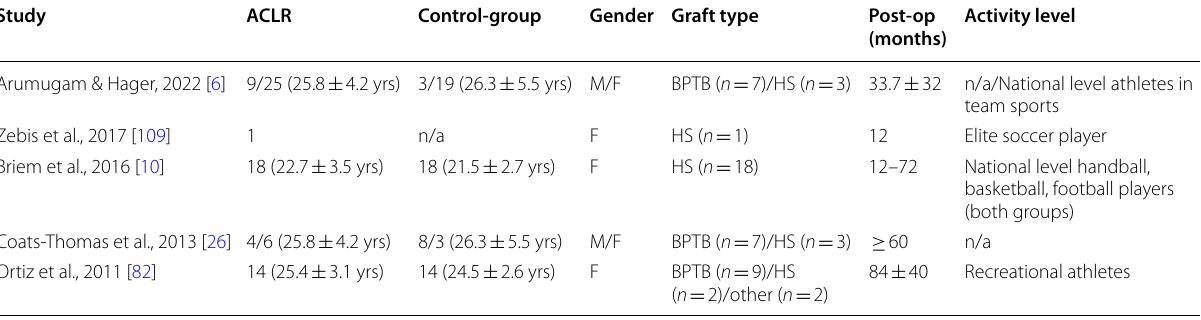
Number in brackets corresponds to reference number; sample size and age in years (mean M Male, F Female, BPTB Bone-patellar tendon-bone graft, HS Hamstrings graft, other autograft other than BPTB or HS, post-op time of testing since surgery in months (mean SD), n/a not ±